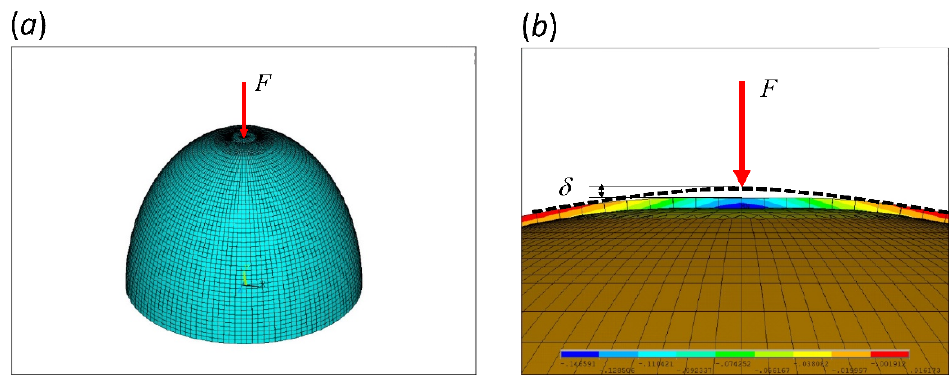
Figure 2. Eggshell models in finite element package ANSYS (Mechanical APDL 15.0). ( a ) a representative mesh of the upper-half eggshell with mesh-refinement near the top. The bottom ring (equator) is fixed. ( b ) a cross-sectional view of the displacement field in the y -direction (upward) subjected to a point load, F , on top. Negative value, marked in blue, represents downward displacement. δ is the displacement at the load application point. This particular case demonstrates the sce- nario of critical thickness.